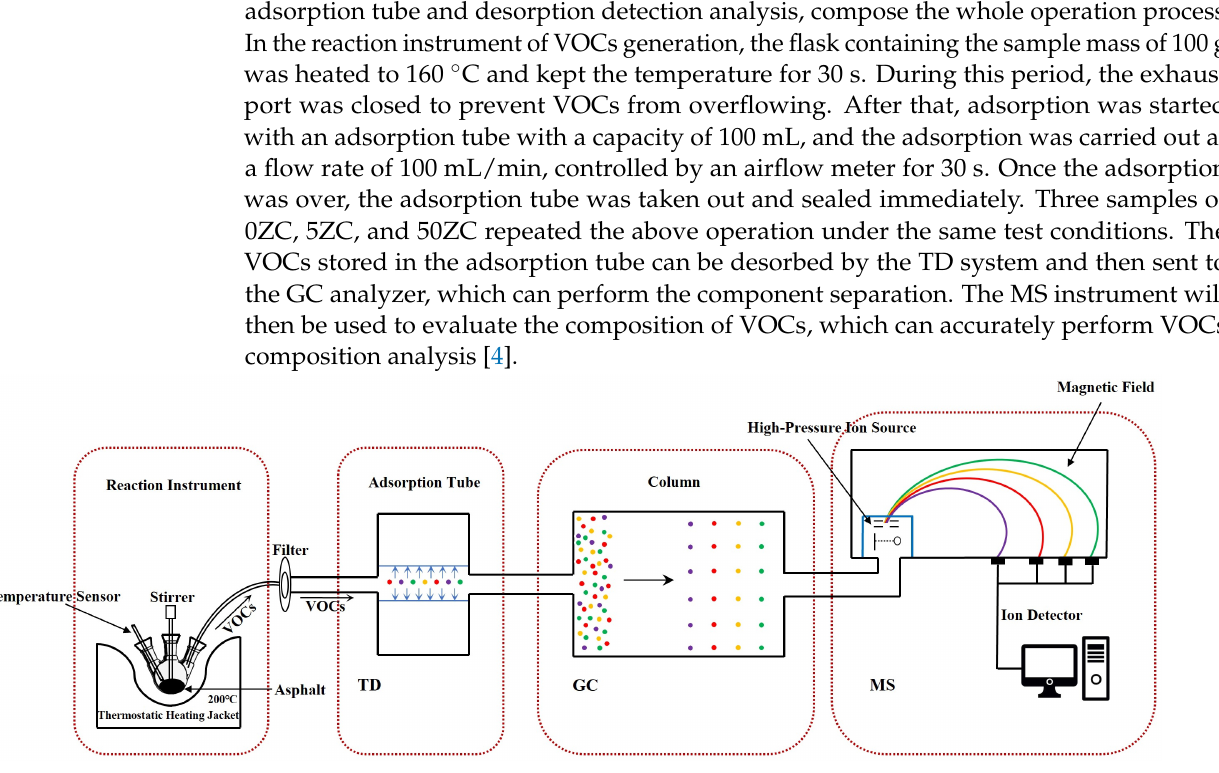
Figure 1. The operation procedure of TD-GC-MS in VOCs.